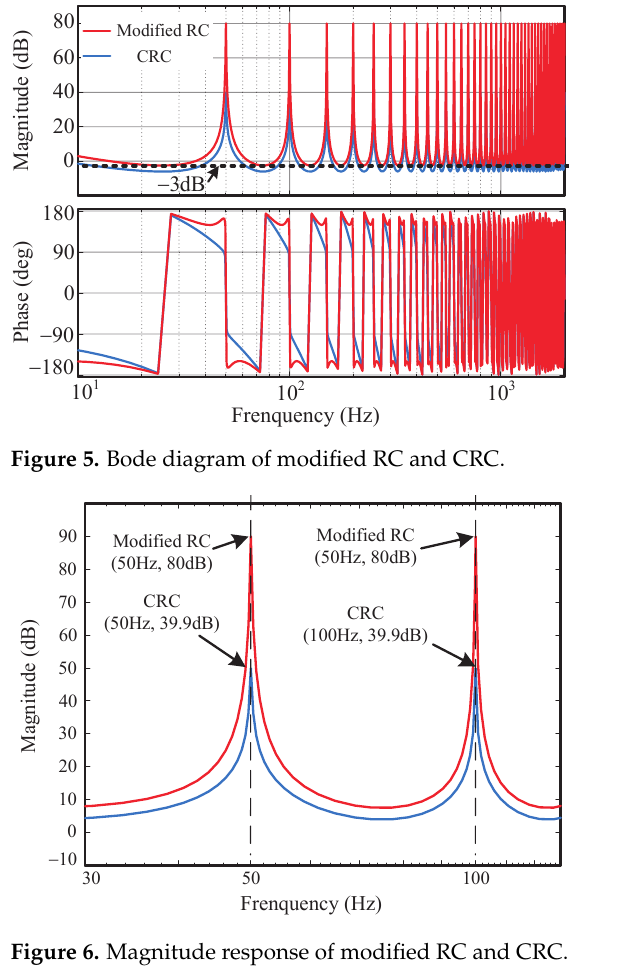
Figure 6. Magnitude response of modified RC and